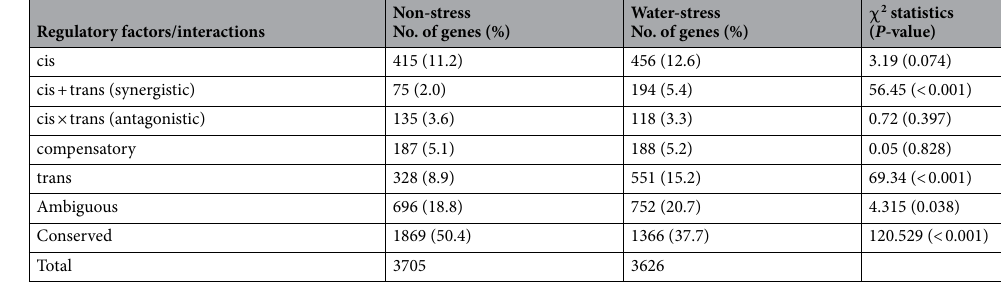
Table 1. Summary of the number of isoforms exhibiting cis and/or trans regulatory divergence between IR64 and Apo under non- and water-stress conditions. χ 2 statistics (with P -values; test for 2 × 2 contingency or two independent proportions with Yates’ continuity correction) indicates the significant difference of the number of isoforms classified in each regulatory category between the two treatments.